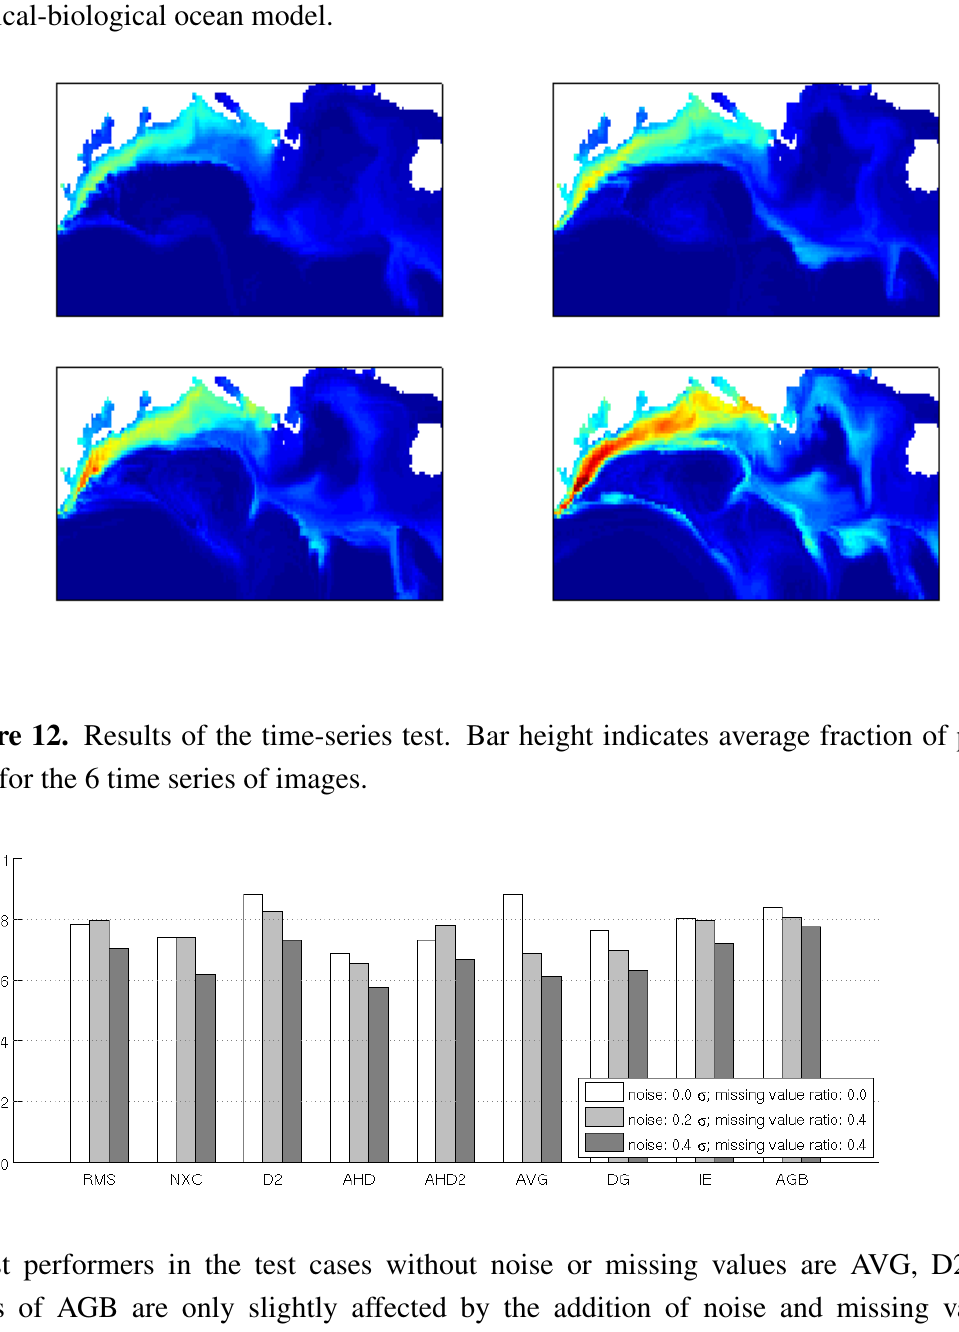
Figure 11. An extraction of 4 consecutive images in a time series of images generated by a physical-biological ocean model.